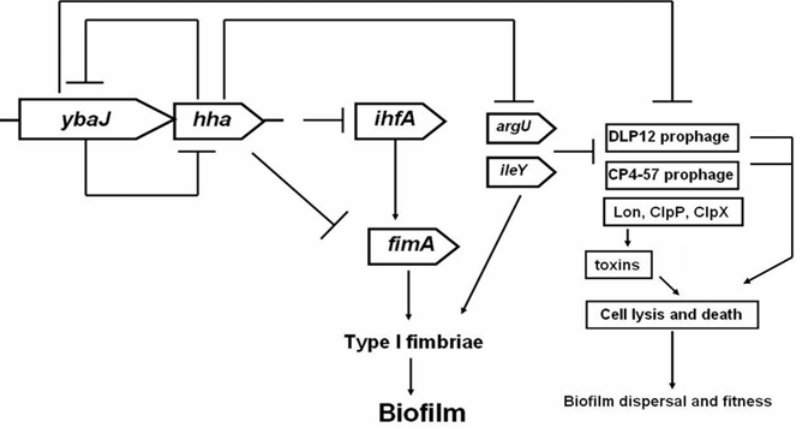
Figure 5. Model for Hha regulation of E.coli biofilm and cell death. R indicates induction, and H indicates repression.